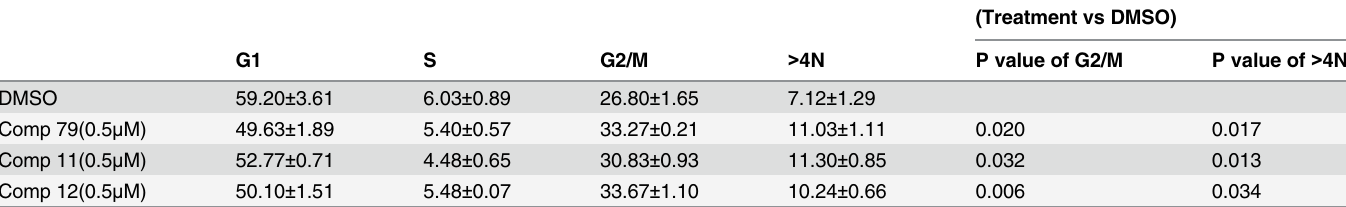
Table 2. T . brucei cell distribution in different phases after the compound treatment. Compared to the control, all three compounds cause cell cycle progression defects in T . brucei cells. FACS results from three independent experiments (mean ± standard deviation) are given.